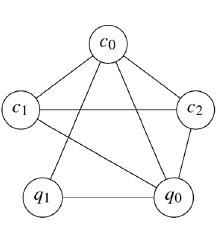
Figure 5. Qubit connections required by the compiled circuit in Fig. 3.